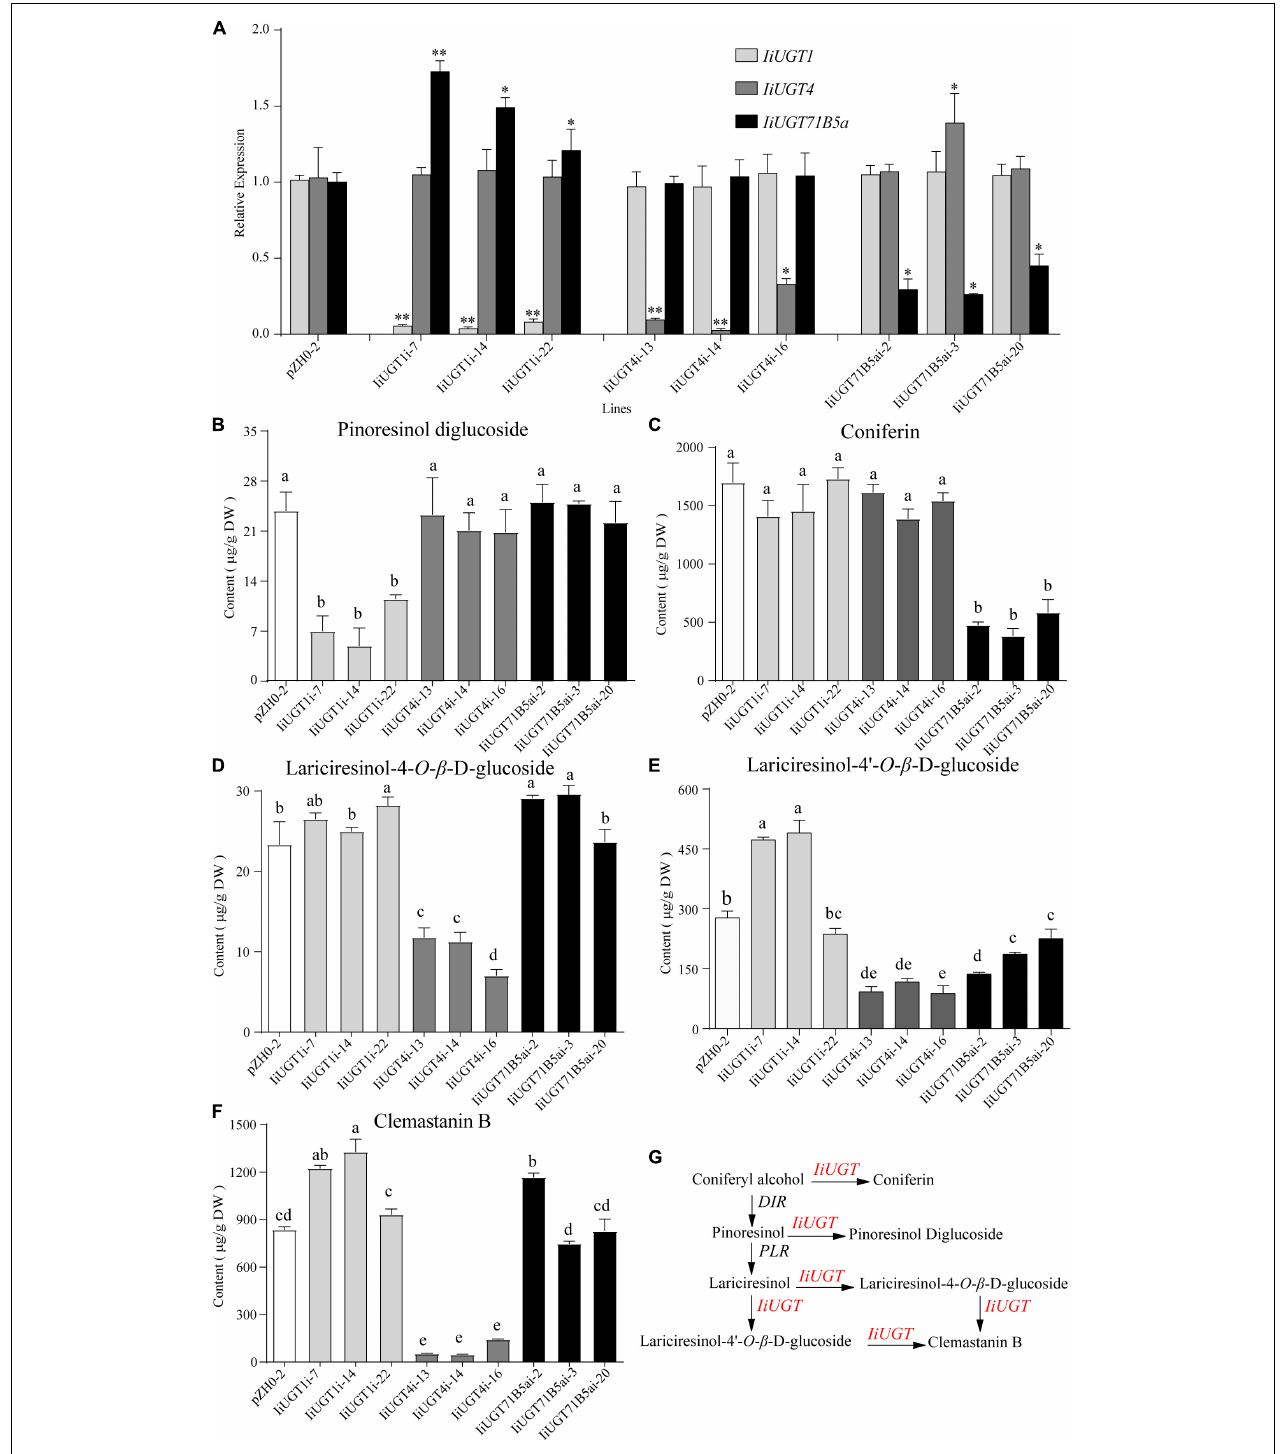
FIGURE 6 | RNA interference silencing of IiUGT1 , IiUGT4 and IiUGT71B5a in I. indigotica hairy roots. (A) Relative mRNA levels of IiUGT in RNAi hairy roots was measured by monitoring relative transcript levels by qRT-PCR. Effect of IiUGT gene silencing on the levels of Pinoresinol diglucoside (B) , Coniferin (C) , Lariciresinol-4- O - β -D-glucoside (D) , Lariciresinol-4 (cid:48) - O - β -D-glucoside (E) , Clemastanin B (F) . Standard errors were calculated from three biological replicates. Different letters above the error bars indicate significant differences ( p < 0.05). Statistical sinificance levels between the variable groups and the control group were calculated using one-way ANOVA test and Tukey’s multiple comparisons test ( ∗ p < 0.05 and ∗∗ p < 0.01). (G) Proposed pathway from coniferyl alcohol to lignan glycosides in I. indigotica .